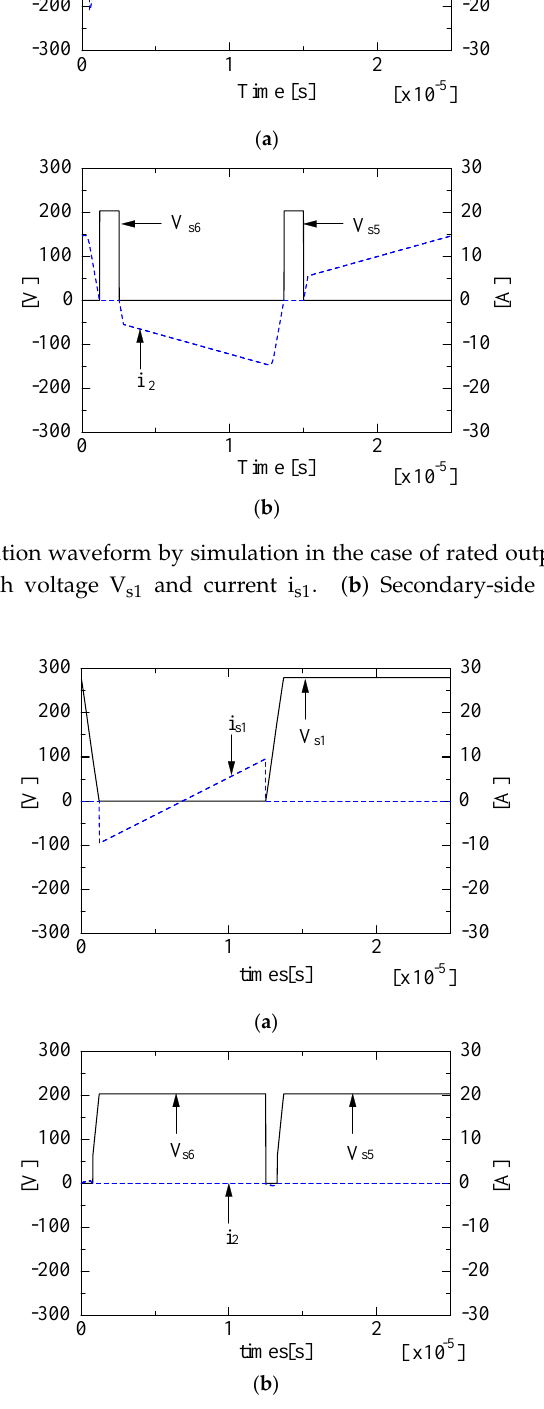
Figure 5. Steady operation waveform by simulation in case of (duty factor = 0). ( a ) Primary-side switch S 1 voltage and current. ( b ) Secondary-side switches voltage and secondary side current.